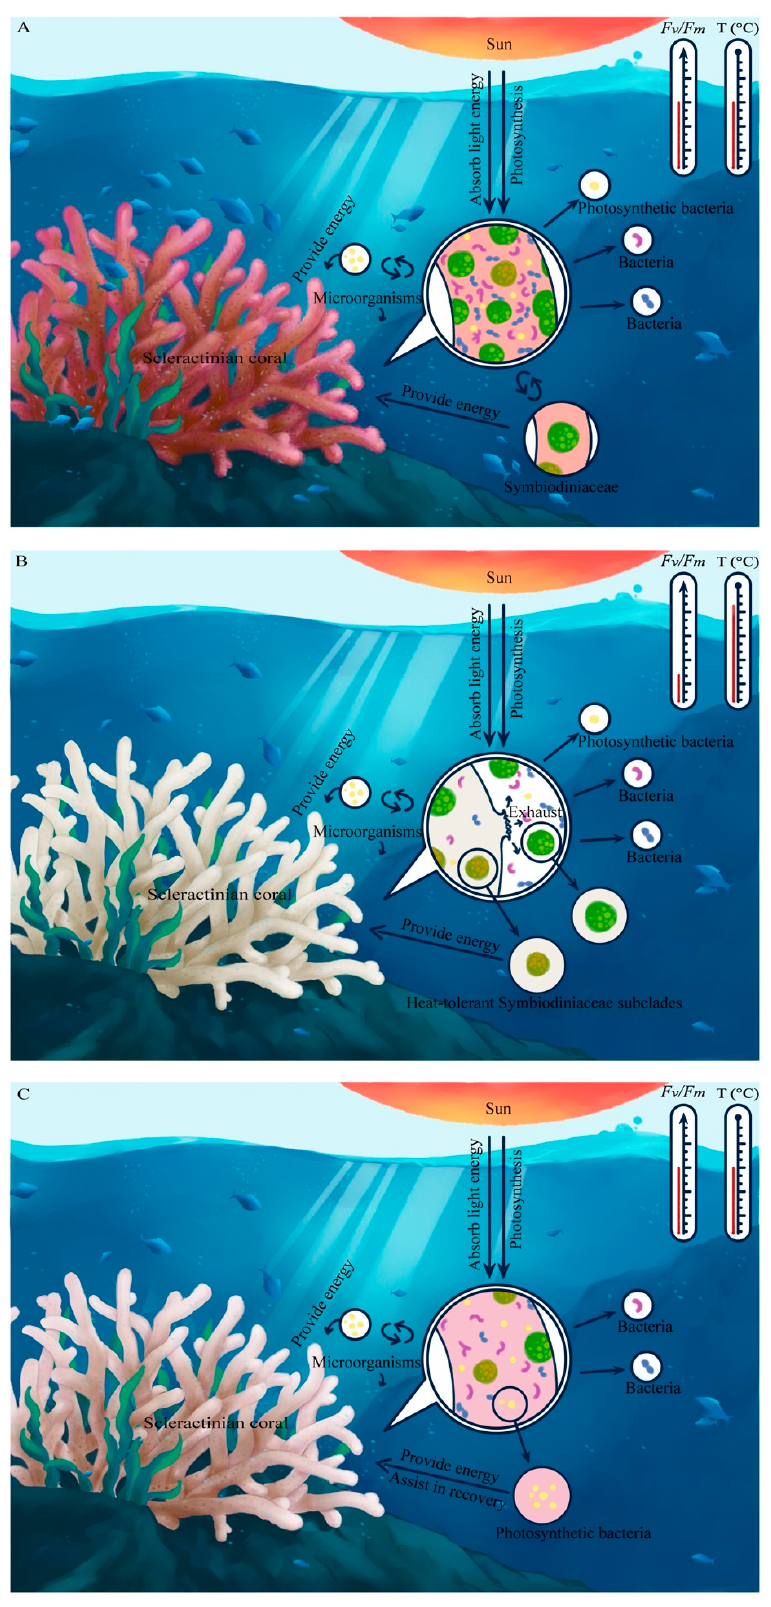
Figure 7. Model of the coordinated response of coral symbionts (Symbiodiniaceae and bacteria) during heat stress. The schematic illustration shows that the coral host, Symbiodiniaceae, and bacteria formed a complex holobiont with an energy supply as the core: ( A ) coral in a state of healthy growth